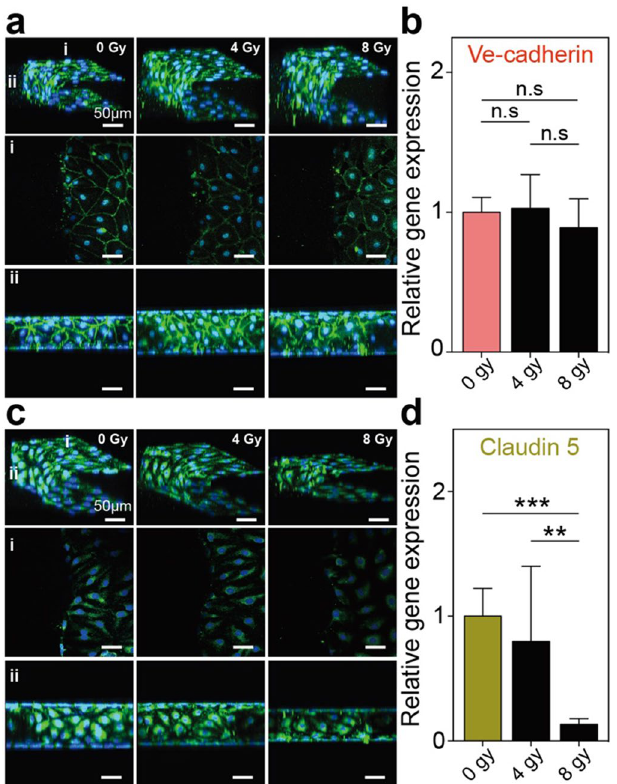
Figure 3. Immunofluorescence images and qRT-PCR for junction proteins (VE-cadherin and Claudin 5) showed delocalized and reduced expression after irradiation. Immunofluorescence images showed ( a ) delocalized VE-cadherin and ( c ) reduced Claudin 5 expression on the hMVECs. In addition, the relative gene expressions of ( b ) VE-cadherin and ( d ) Claudin 5 after the gamma irradiation exposure corresponded to the immunofluorescence images (scale bar: 50 µm; * p < 0.05; ** p < 0.01; *** p < 0.001, n = 2–3). Statistical comparison were calculated with two-tailed t-tests using Prism (7.0a, GraphPad software, www. graph pad. com). Images and graphs were created with Adobe illustrator (CC 2019 23.0.1, www. adobe.